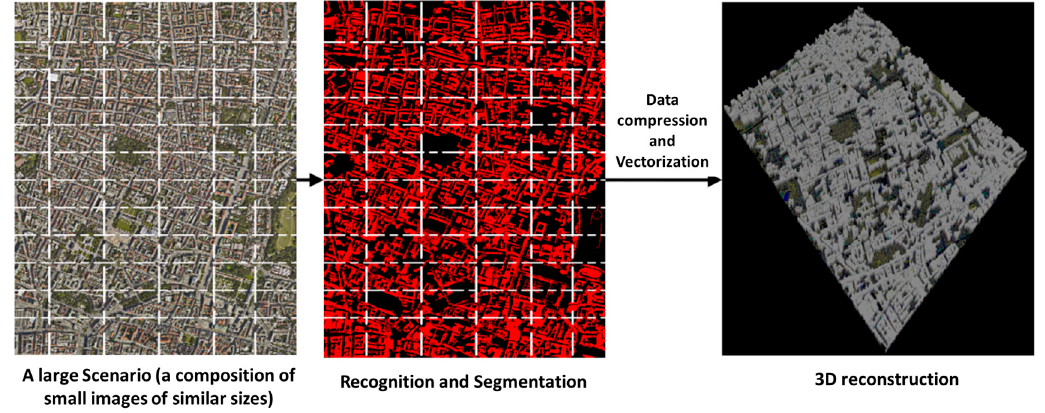
Figure 4. Work flow of the 3D outdoor environment reconstruction.